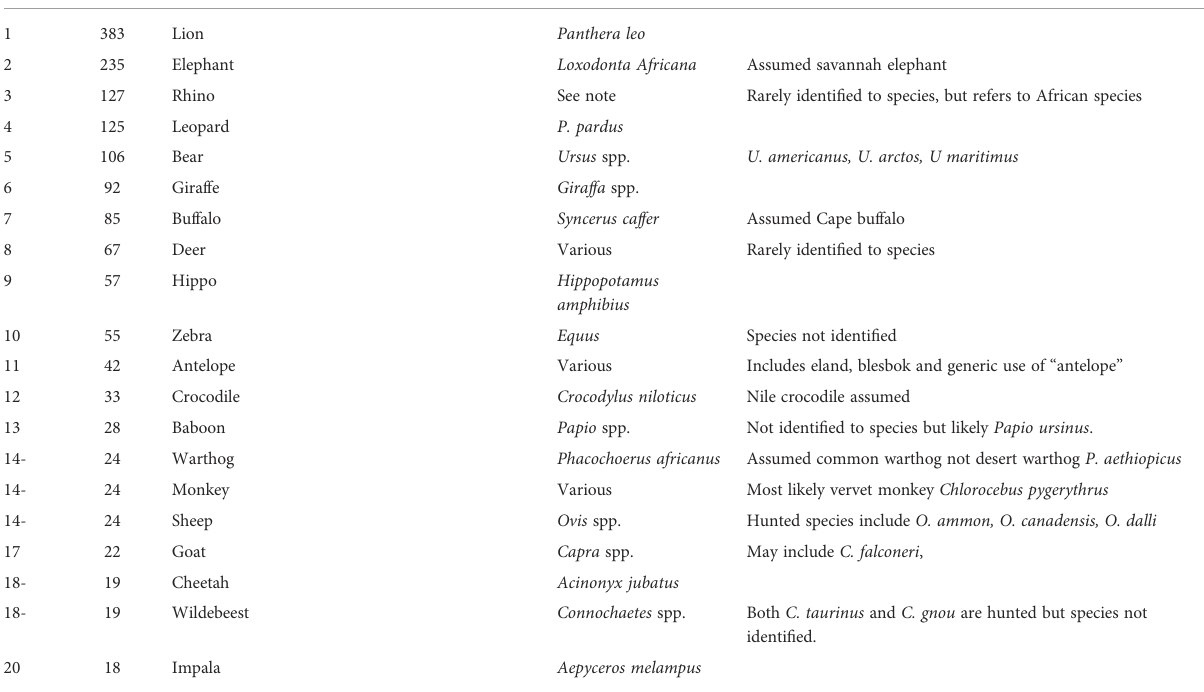
TABLE 1 The top 20 animals mentioned in articles. Rank Mentions Common name or name used in